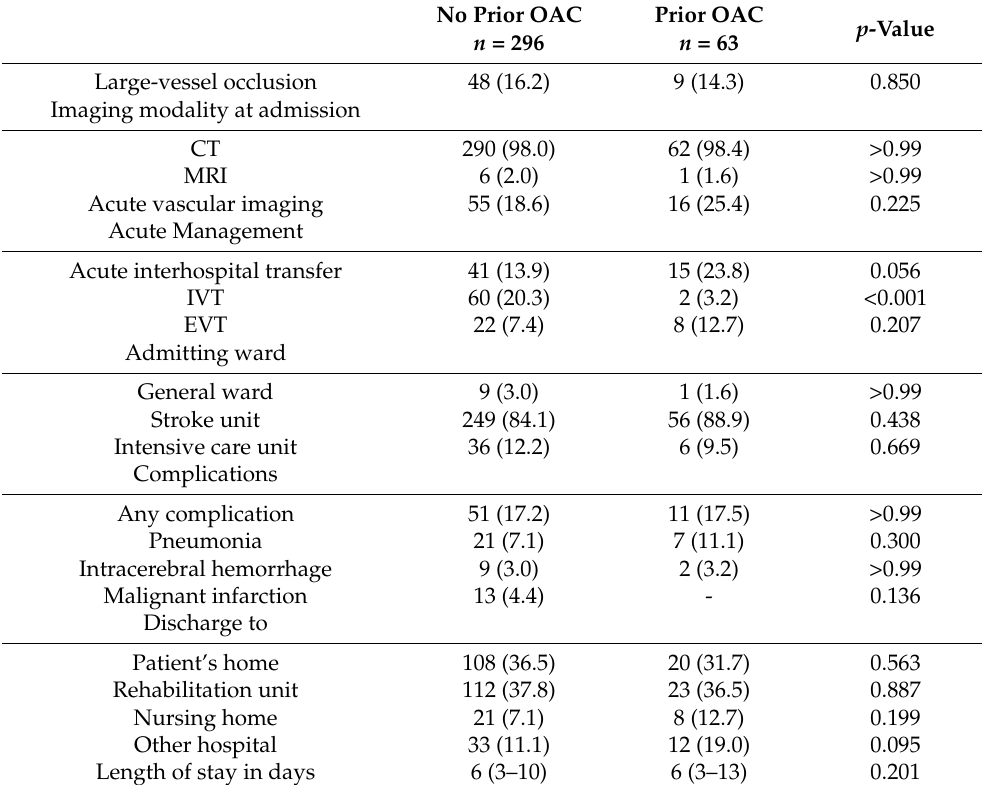
Table 2. Management of patients with ischemic stroke categorized according to anticoagulation status at admission ( n =